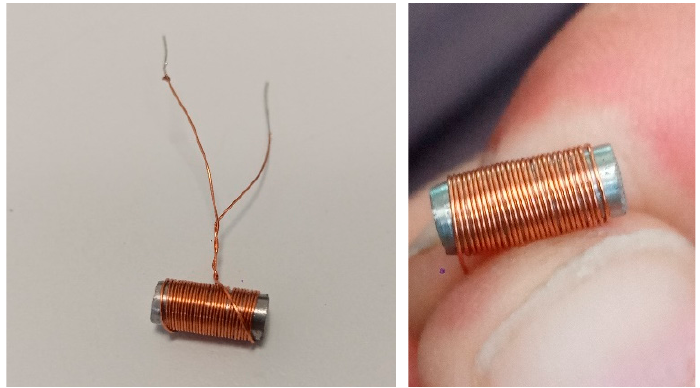
Figure 6. Rod sample preparation for the test: winding process and size.